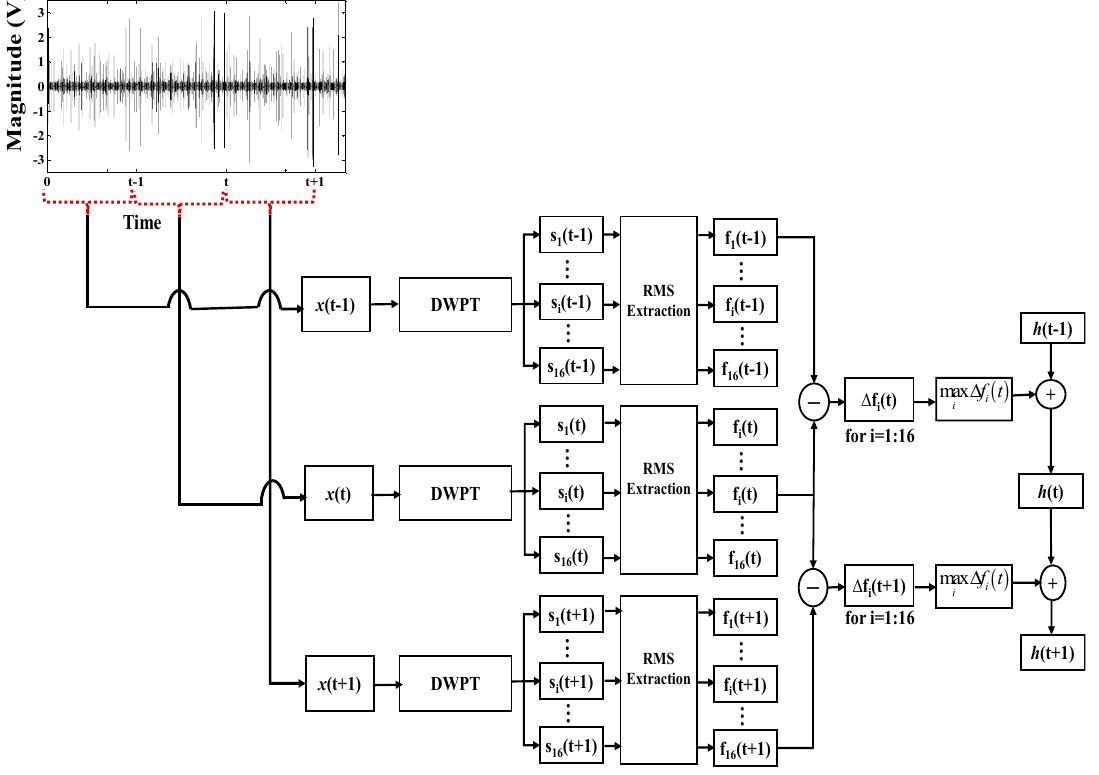
Figure 2. Process of evaluating the RMS trends obtained from different sub-bands and the construction of the optimal health indicator.